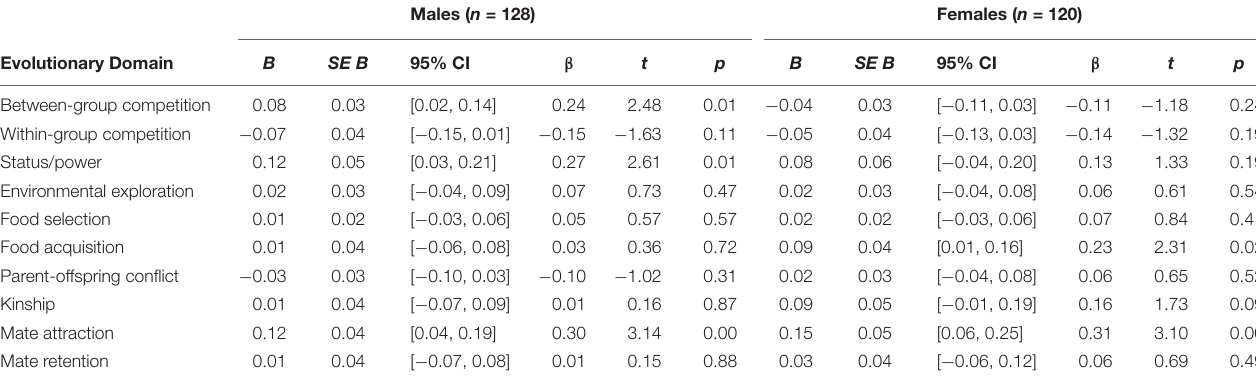
TABLE 9 | Multiple regression analysis for risk propensity-context predicting risk-taking behaviors. Males ( n = 128) Females ( n = 120) Evolutionary Domain